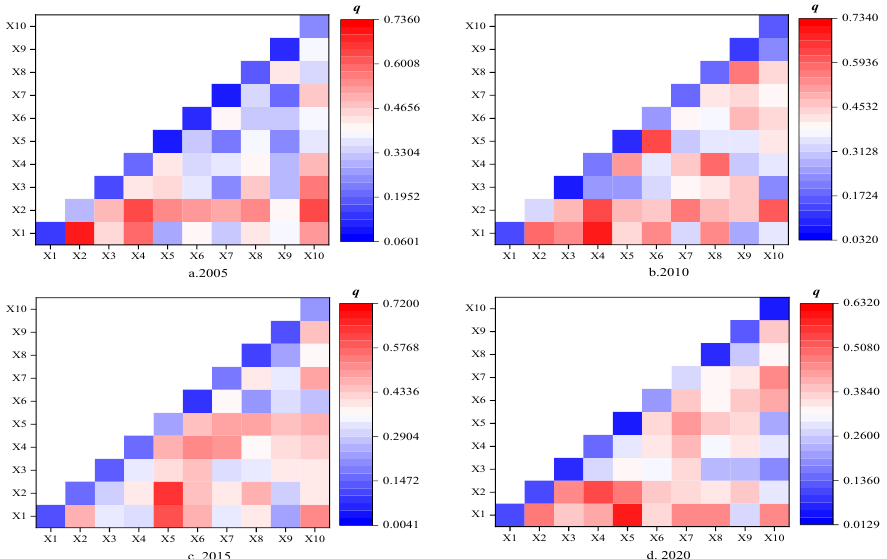
Figure 6. The detection results for the dual-factor interaction of the spatial-temporal evolution of the multifunctional coupling coordination degree of cultivated land in the study areas in 2005, 2010, 2015, and 2020.